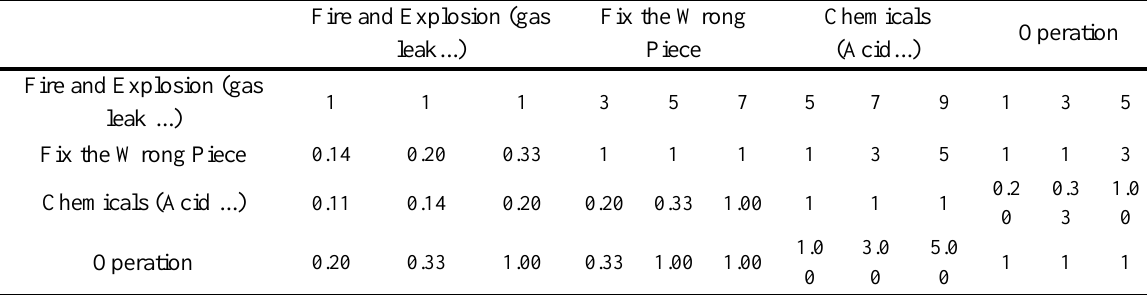
Table 7. Compensation coefficient calculation of equipment safety